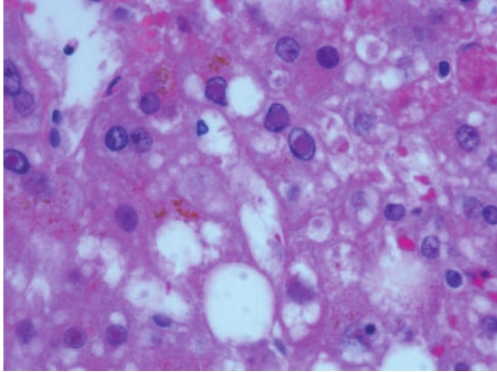
Figure 2: Viral inclusions are readily visible in infected hepatocytes.